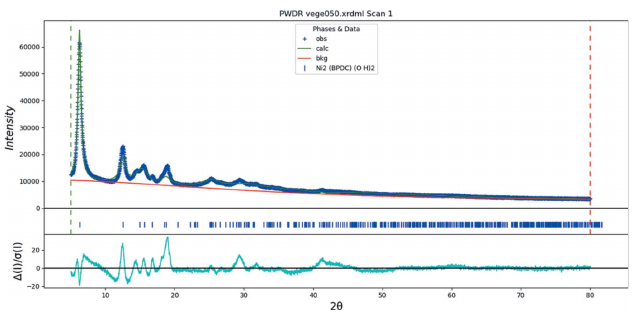
Figure 13 The Rietveld plot for the refinement of Ni 2 BPDC(OH) 2 . The blue crosses represent the observed data points, and the green line is the calculated pattern. The cyan curve is the normalized error plot. The row of tick marks indicates the calculated reflection positions.